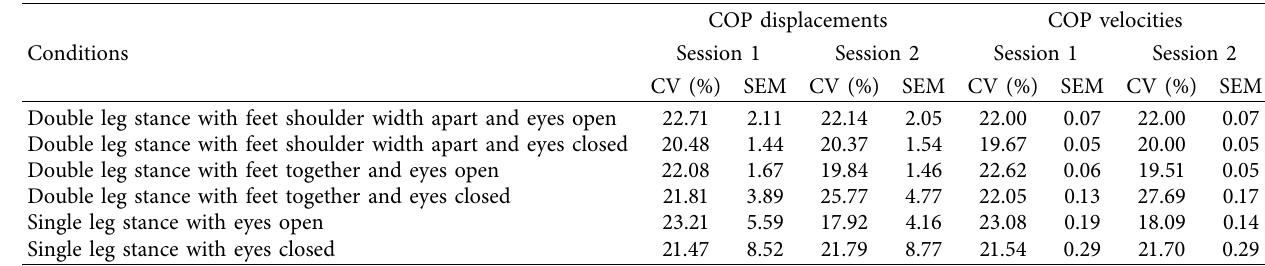
Table 3: Results of coefficients of variation (CV) and standard errors of measurement (SEM) of COP displacements (cm) and COP velocities (cm/second) of six conditions in sessions 1 and 2.